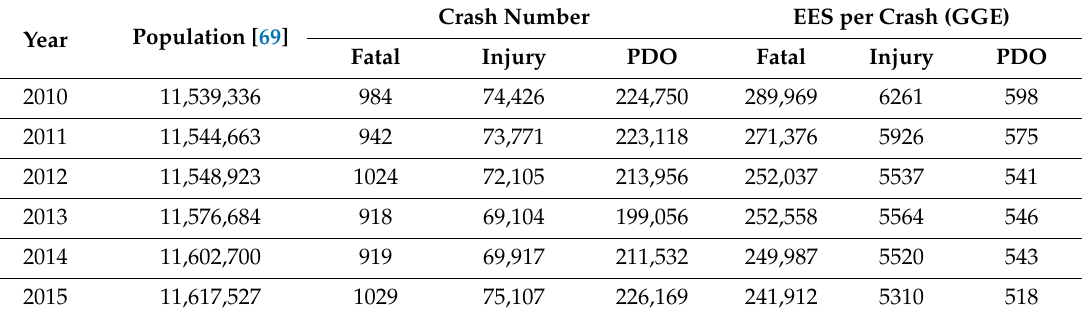
Table 7. EES analysis for the State of Ohio.